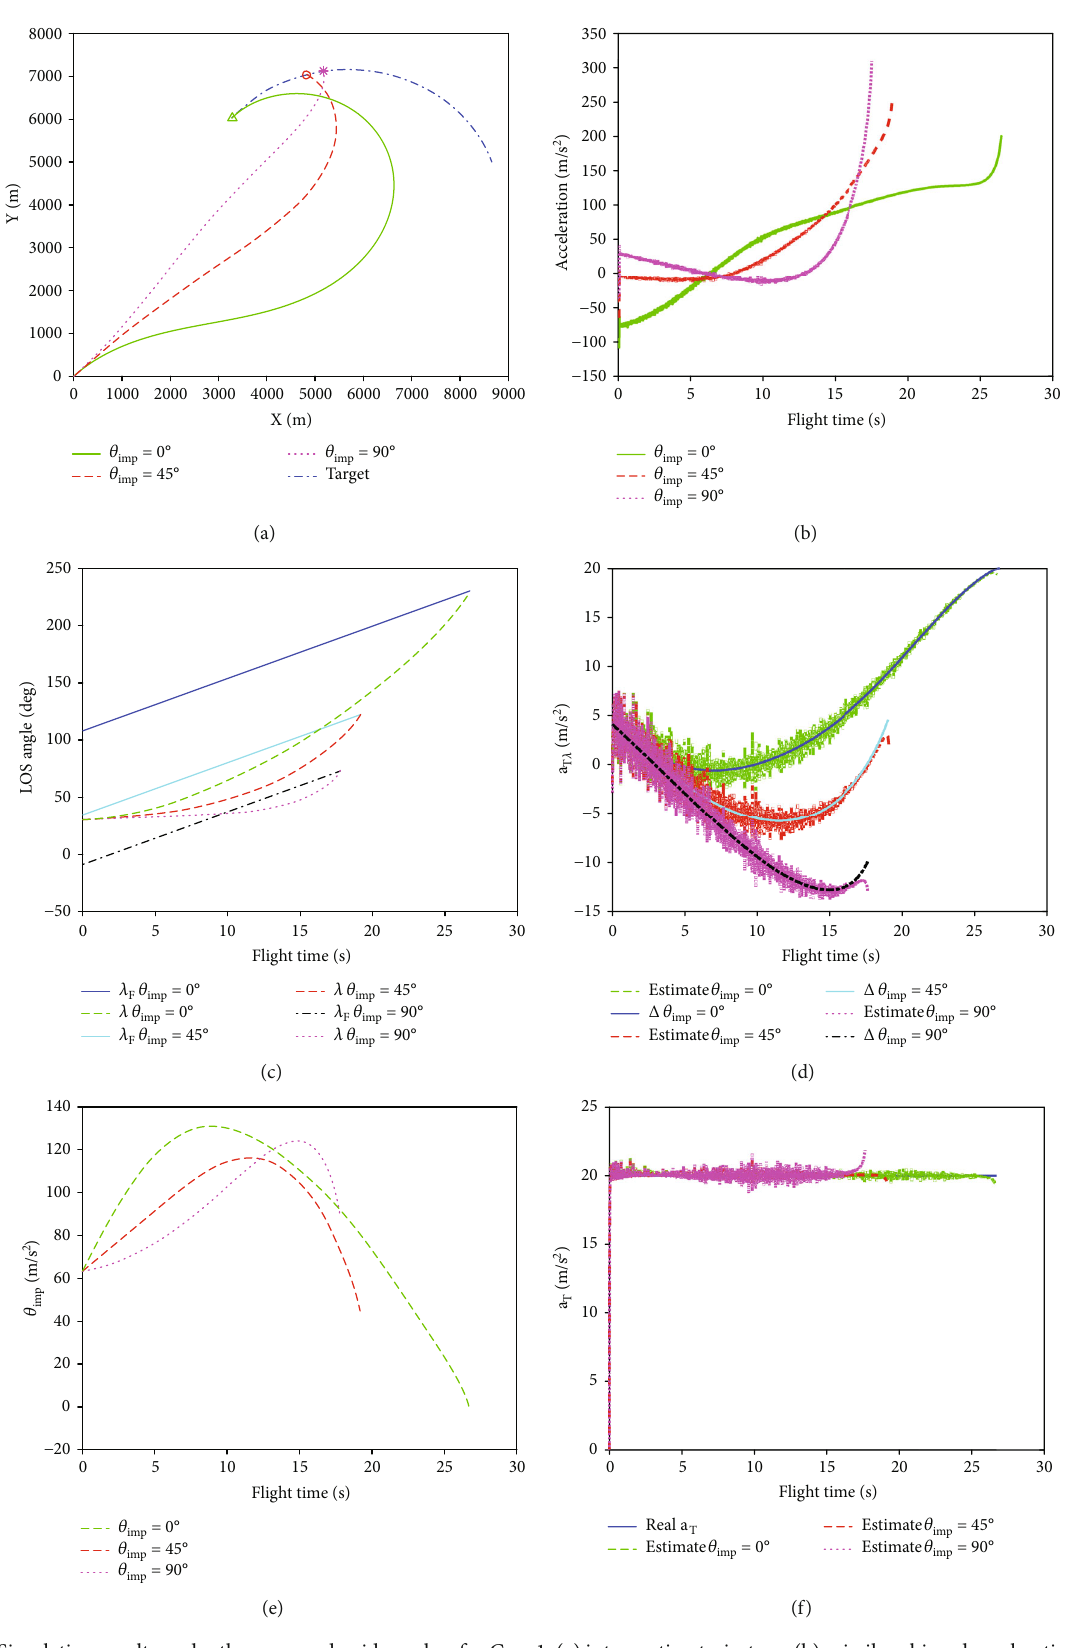
Figure 3: Simulation results under the proposed guidance law for Case 1: (a) interception trajectory; (b) missile achieved acceleration; (c) LOS angle pro fi le; (d) target maneuver projection estimation; (e) impact angle pro fi le; and (f) target maneuver